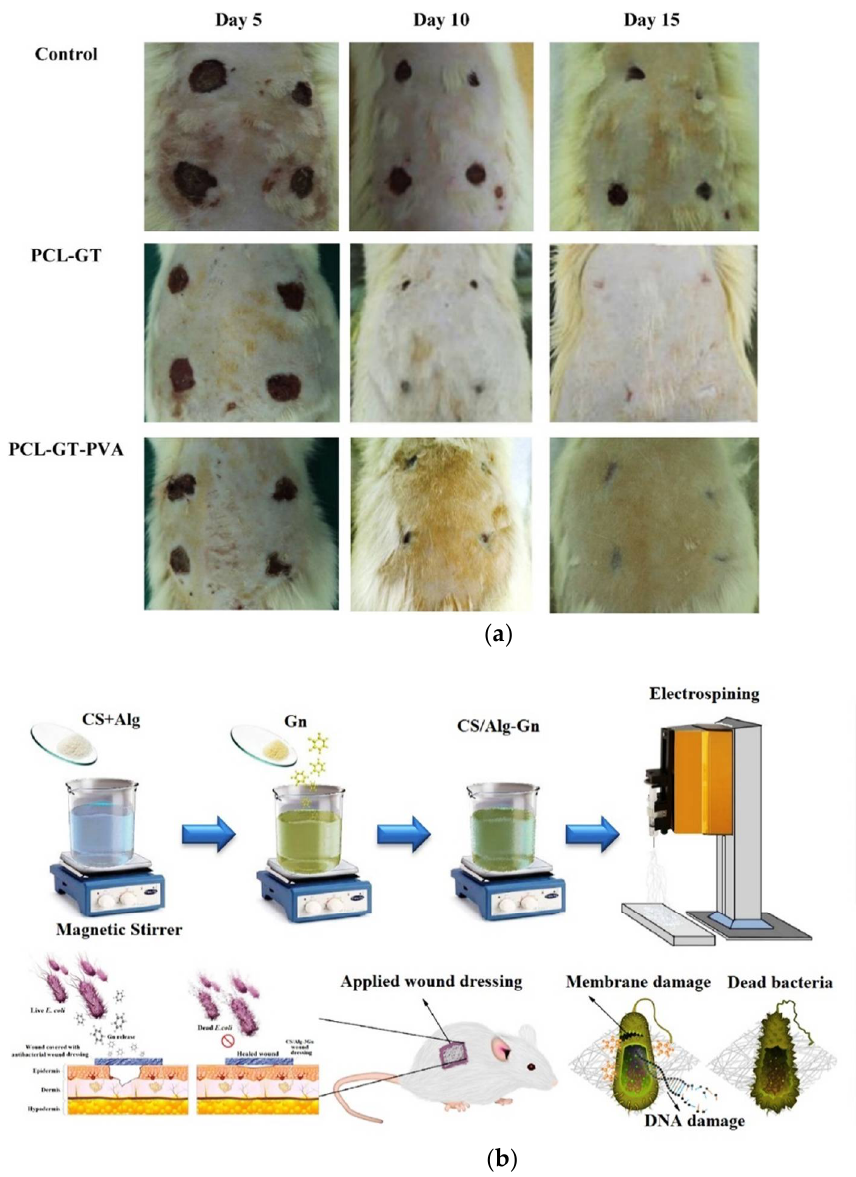
Figure 8. A schematic illustrates the fabrication of ( a ) Wound closure for rats after 5, 10, 15 days (two above wounds treated with acellular scaffolds and two lower wounds treated with cellular nanofibers (reproduced from [109] with permission of Elsevier, 2020), and ( b ) CS/Alg-Gn electrospun nanofibers (reproduced from [110] with permission of Elsevier, 2019).